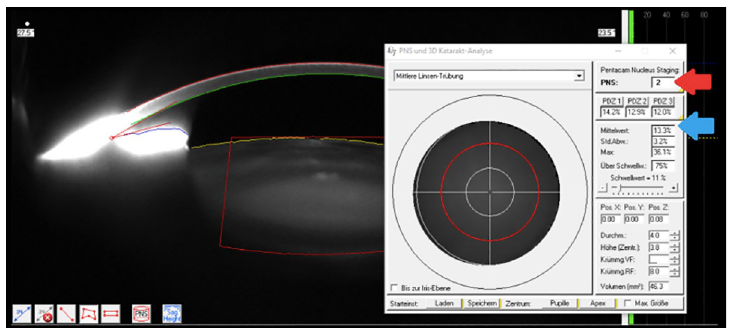
Fig 1. PentacamHR 1 Nucleus Staging (PNS) module. PentacamHR 1 Nucleus Staging (PNS) module showing a Scheimpflug cross-sectional image of the anterior eye segment and lens densitometry with PNS value (red arrow) and mean lens densitometry (blue